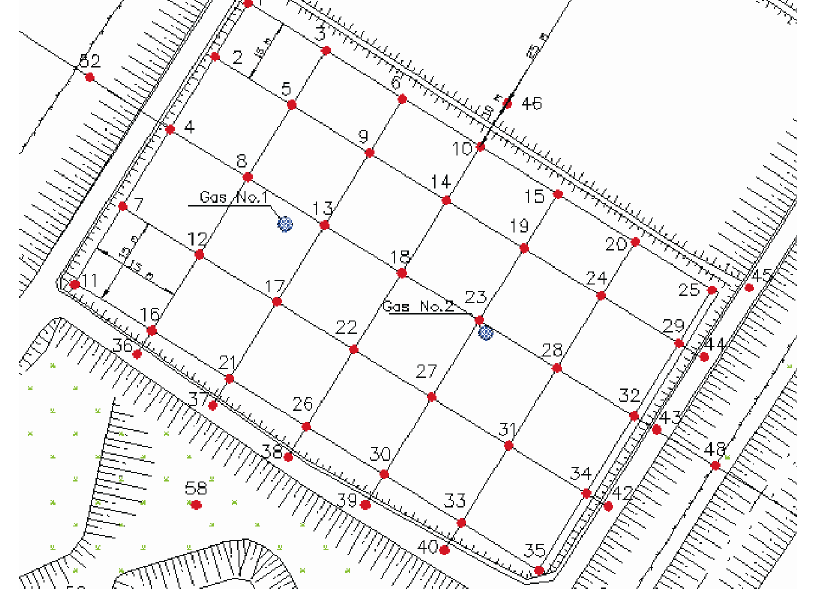
st section of Jerubaičiai